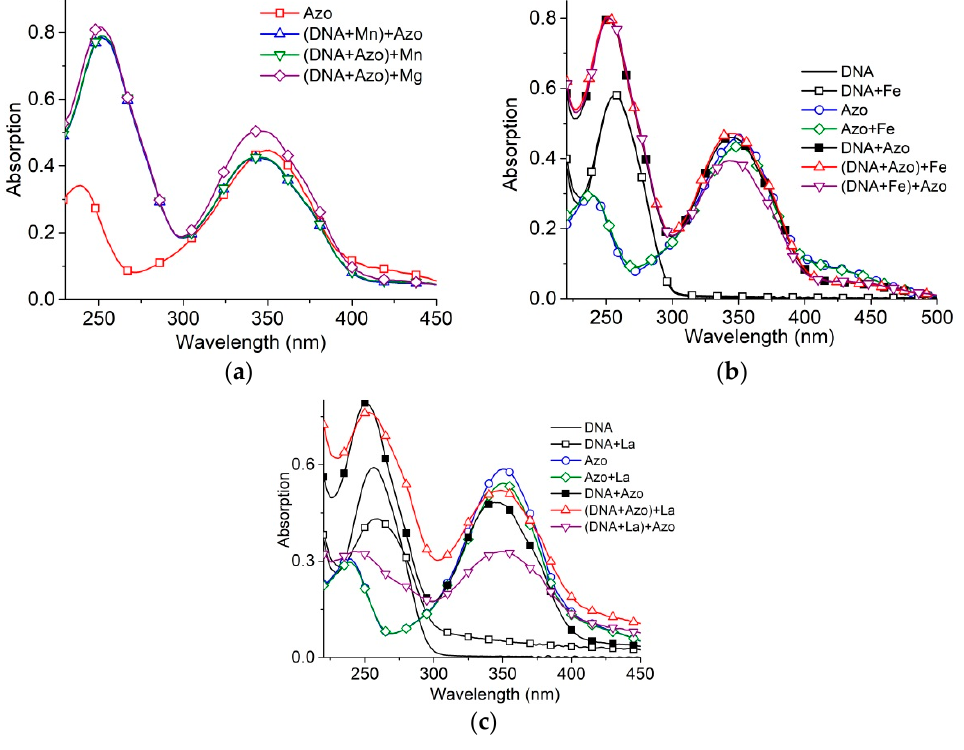
Figure 7. Surfactant absorbance spectra in complexes with DNA in solutions with Mg 2+ and Mn 2+ ( a ); Fe 3+ ( b ); La 3+ ( c ) in 0.005 M NaCl. Brackets indicate the initial complex. [Mn] = 1 × 10 − 5 M, [Mg] = 2 × 10 − 3 M, [Fe] = 1 × 10 − 5 M, [La] = 1 × 10 − 4 M. [AzoTAB] = 3 × 10 − 5 , [DNA] = 9 × 10 − 5 M(P), z = 0.3.